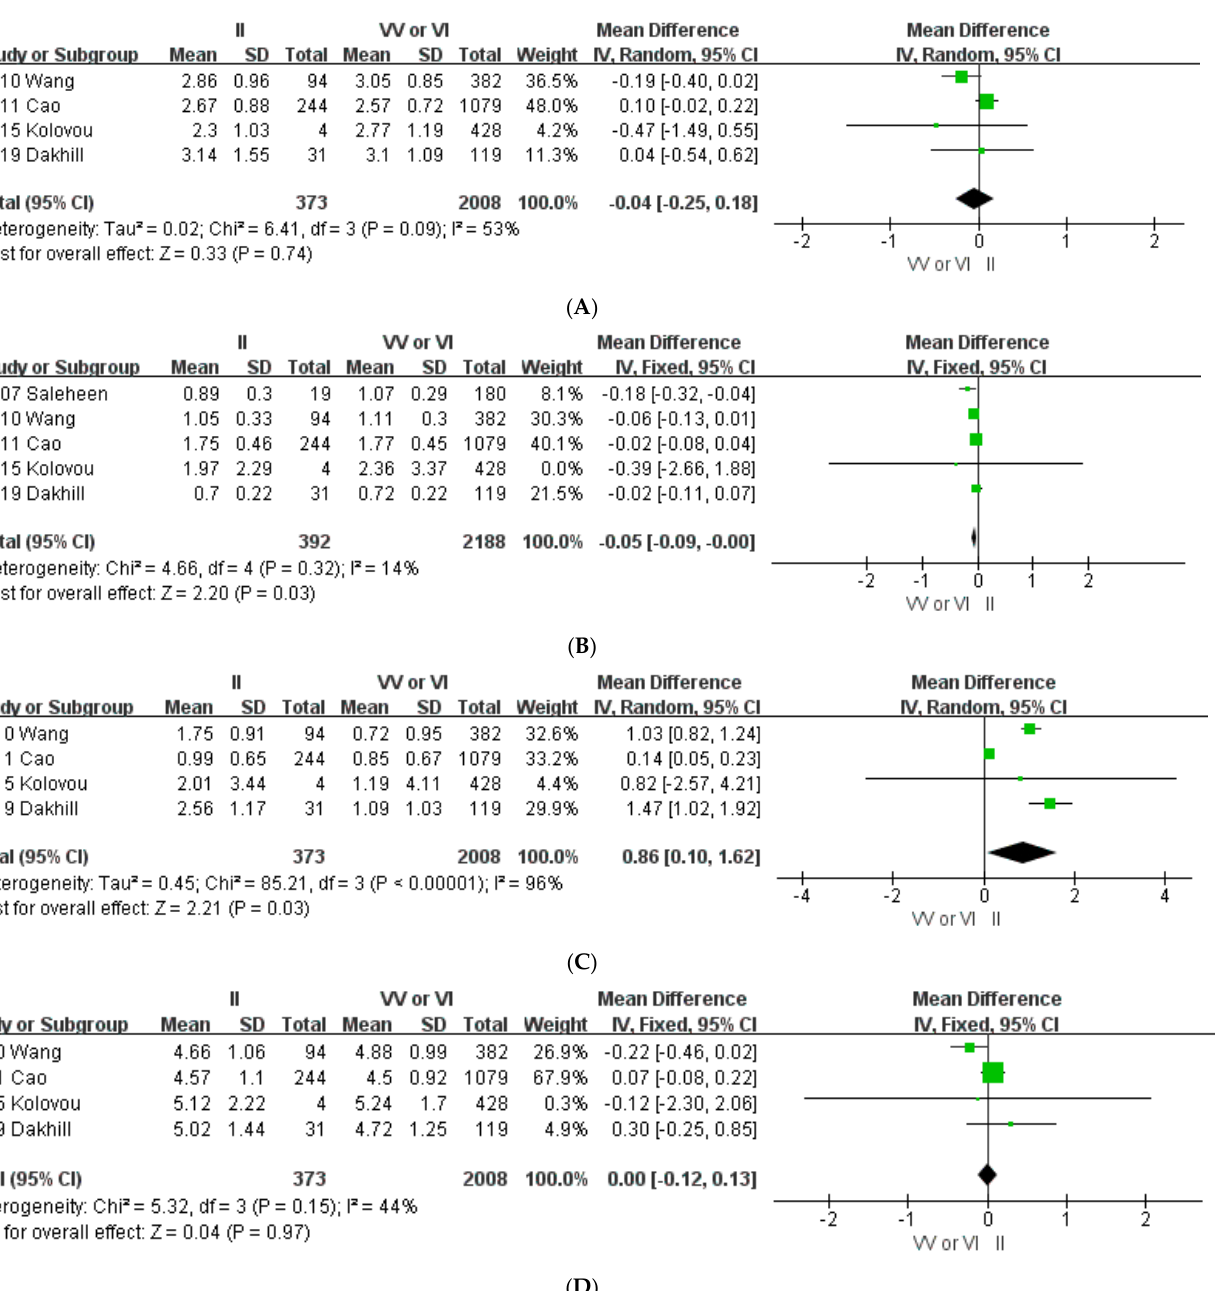
Figure 2. Forest plots demonstrating the association between the ABCA1 69C>T polymorphism and lipid level (mmol/L).